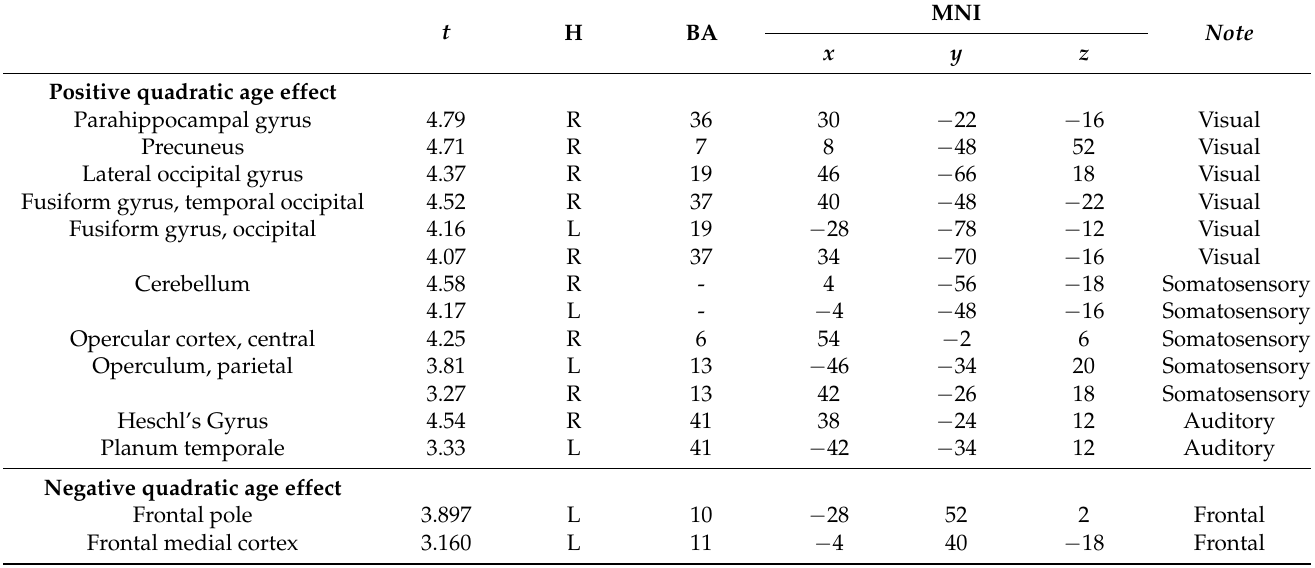
Table 1. Significant brain regions of quadric age effects (cluster threshold at Z = 3.1 and corrected p -value at 0.05 after 5000 permutation) on the LC seed-based whole-brain connectivity analysis. t = t-value; H = hemisphere; BA = Broadman area; Region labeling is based on Harvard–Oxford